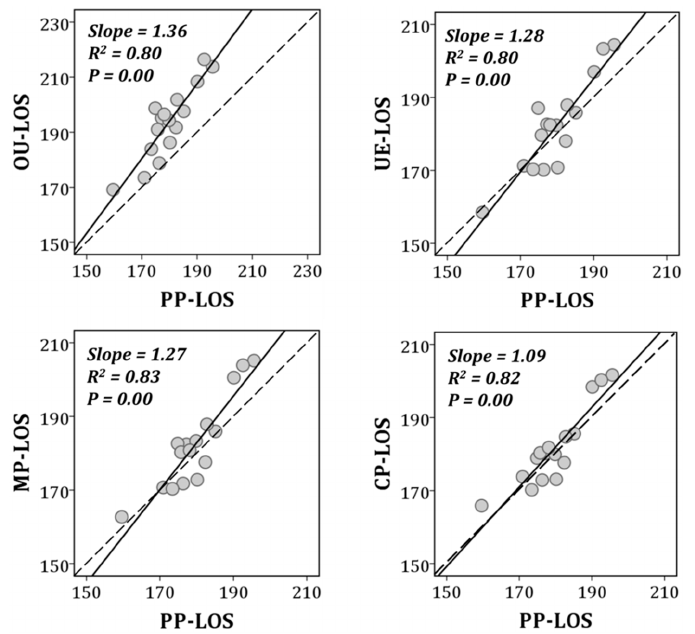
Figure 8. Relationship between pure pixels (PP) and other four land cover types for length of season (LOS).